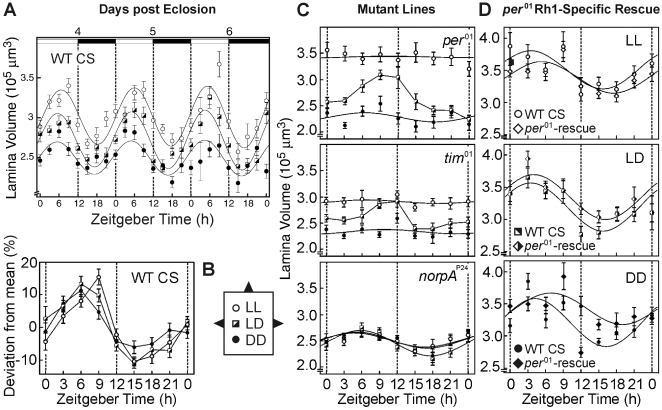
Structural plasticity of the lamina is controlled by the parallel action of a circadian clock and a phototransduction-dependent mechanism.
a, Lamina volumes of adult wild-type CS (WT CS) flies kept under LL, LD, or DD conditions during adult life. All flies had experienced 12:12 LD cycles throughout larval and pupal development. The lamina volume oscillated in a circadian manner around a mean value which was larger in light-experienced flies than in dark-reared flies (F(2,1699)  = 156.7, p<0.0001, ANOVA). Sinusoidal-function fitting revealed a best fitting period of 23.7 h for LL (F(1,563) = 17.5, p<0.0001) and DD (F(1,515) = 5.6, p<0.05) lamina volume oscillations and 24.0 h for LD (F(1,621) = 34.2, p<0.0001). ‘Circadian Time’ (for LL and DD) ZT 0  =  light on, ZT 12  =  light off; for LL- and DD-flies read ZT as ‘Circadian Time’. b, Calculated amplitude deviations from the respective mean lamina volumes of all data points in a. Light experience significantly modified the time course of the circadian lamina-volume oscillations. This is most apparent at ZT 9, where LL reared flies showed the highest volume and DD reared flies the lowest volume. c, Lamina volumes of 10 to 15 adult mutant male flies per point of time kept under LL, LD or DD conditions. Circadian volume oscillations of the lamina were absent in the two clock mutants per01 and tim01 reared under LL- or DD-conditions. LD-reared animals displayed an increase in lamina volume during the day and a rapid decrease at night. The blind norpAP24 mutant displayed a robust circadian rhythm of lamina volumes. Under all rearing conditions the mean lamina volume rested at the DD-level of wild-type flies. d, Rescue of circadian lamina-volume oscillations in per01-mutants by the transgenic expression of PER-protein exclusively in photoreceptor cells R1-6 using per01; Rh1(−180)-per−1/+ flies. LD-reared R1-6-rescue flies displayed lamina-volume oscillations which were statistically indistinguishable in amplitude and time course from those of WT CS flies. Constant LL - or DD-conditions delayed the subjective day peaks by several hours in R1-6-rescued animals compared to wild-type flies. These observations are consistent with a previously described delay of the PER-protein cycle under DD-conditions in animals of the same genotype. For genetic reasons, in this experiment female flies were used. They were raised under LD-conditions up to their second day of adulthood before being reared for two more days in LL, LD or DD (n = 8 to 10 per point of time). Note that the overall lamina volume in females is higher than in males.